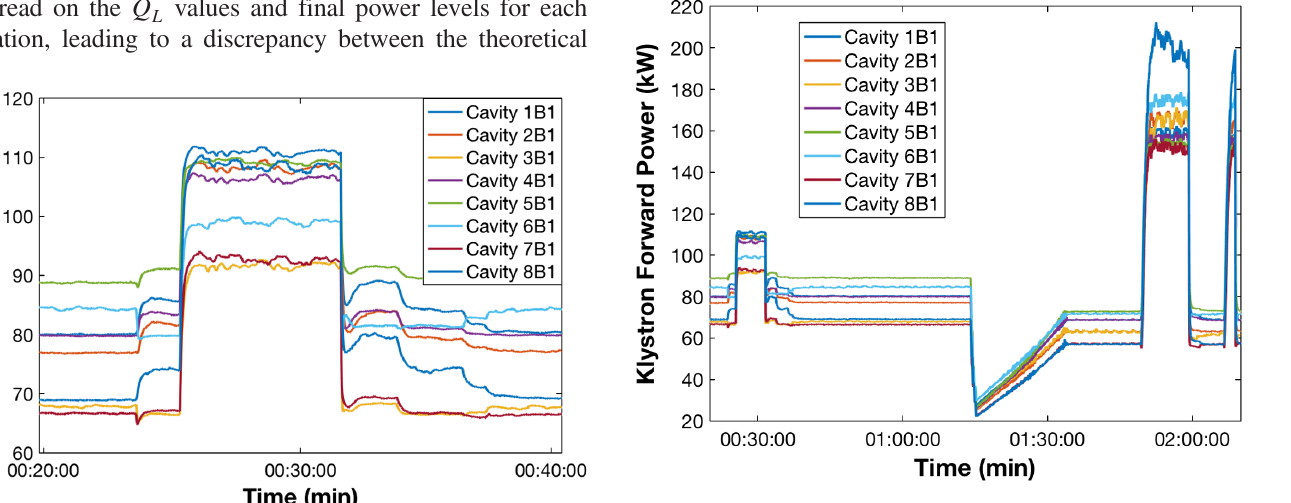
FIG. 8. Average klystron forward power. 204 bunches, beam 1.